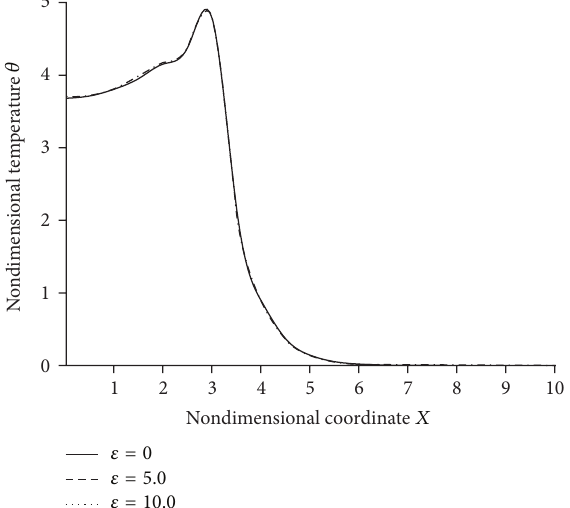
Figure 9: Nondimensional displacement distribution for different 𝜀